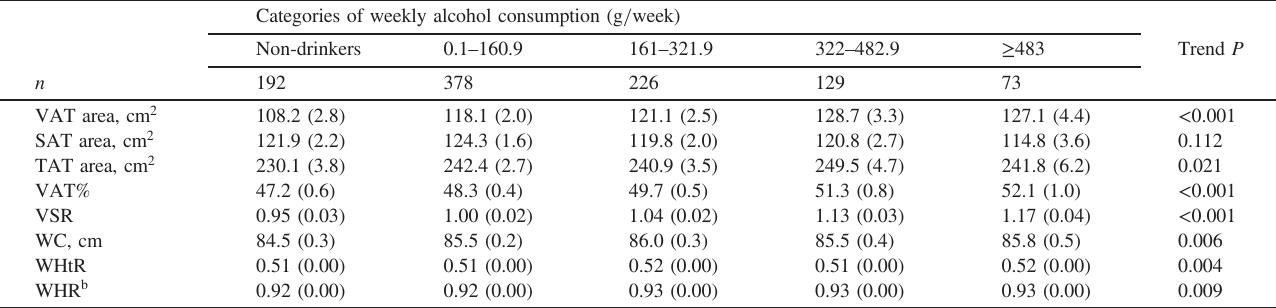
Table 3. Adjusted mean values a of abdominal fat deposition indices according to weekly alcohol consumption in 998 men aged 40 – 79 years after further adjustment for BMI (SESSA, Shiga, Japan, 2006 –